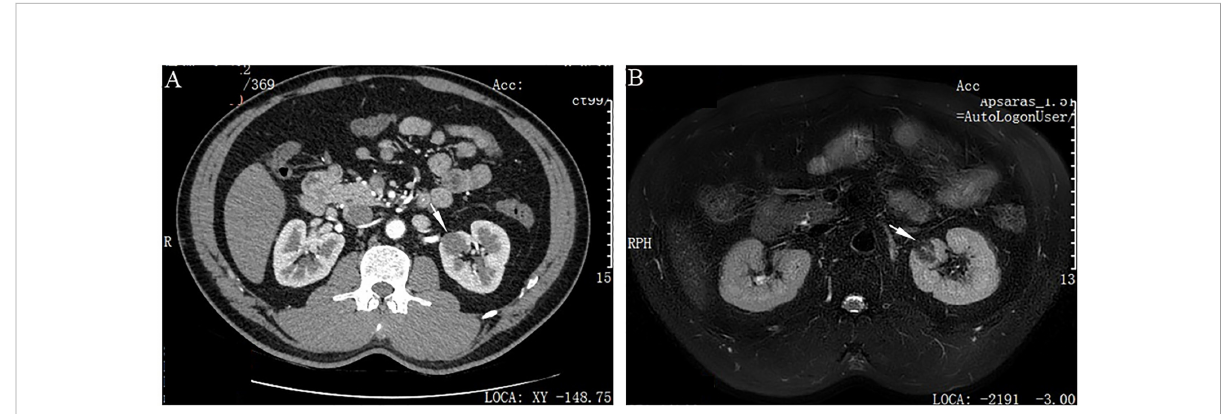
FIGURE 1 Imaging features of adult metanephric stromal tumor with BRAF V600E mutation. (A) Computed tomography scan shows a slightly enhanced, well-de fi ned, oval mass (white arrow), in the upper pole of the left kidney. (B) Magnetic resonance imaging demonstrates that the mass has low-signal intensity on T2-wighted imaging (white